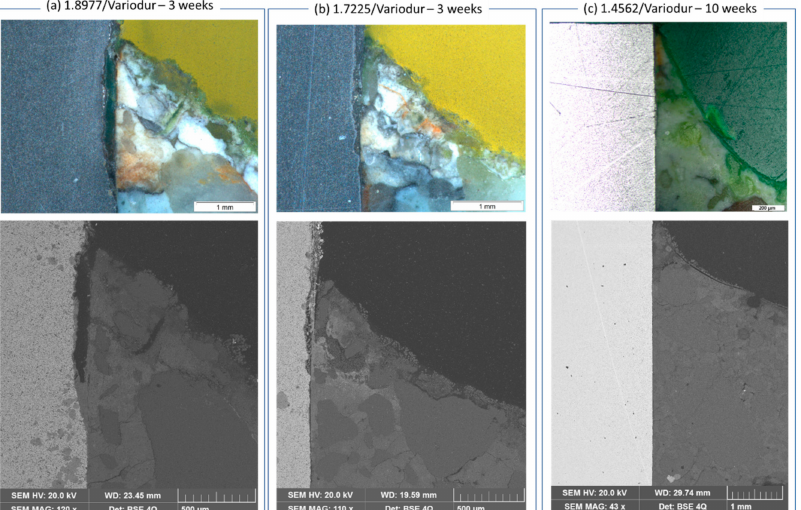
Figure 10. Crevice corrosion at the steel/Variodur interface after exposure to 333 K, 10 MPa, and synthetic aquifer fluid. Crevice formation from the top. The upper row images were taken by a stereomicroscope, while the image (right) below was taken by back-scattered electrons in the same region of interest. In contrast to ( a ) 1.8977 and ( b ) 1.7225 (exposed for 3 weeks), ( c ) 1.4562 did not show any sign of crevice corrosion even after 10 weeks of